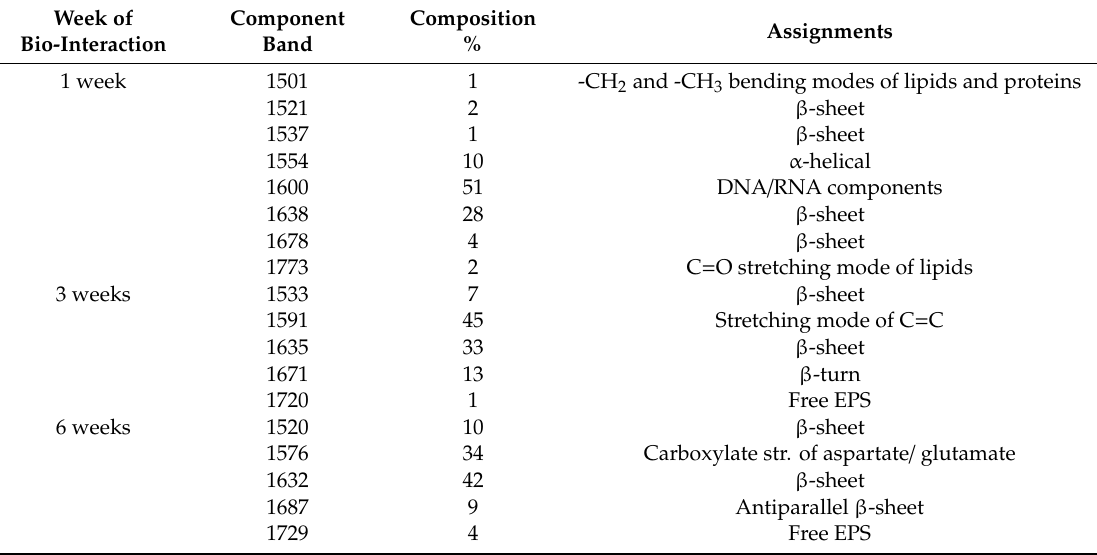
Table 2. Assignments and % composition of the amide I–amide II band components in the 1500–1800 cm − 1 spectral range during bio-interaction of A. ferrooxidans bacterial cells with chalcopyrite